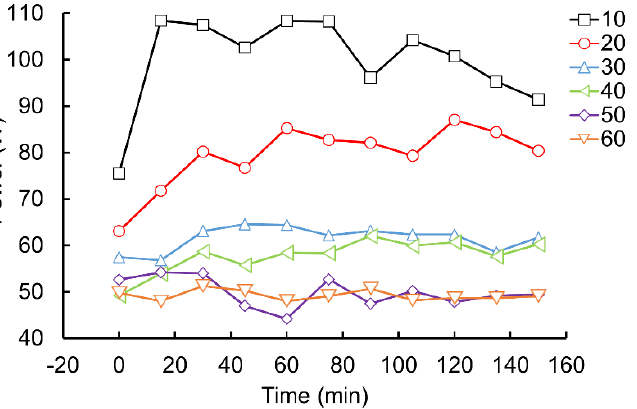
Figure 13. Effect of preload torque at the Junction Surface of Ultrasonic Horn on the Power of Acoustic Vibration Component.